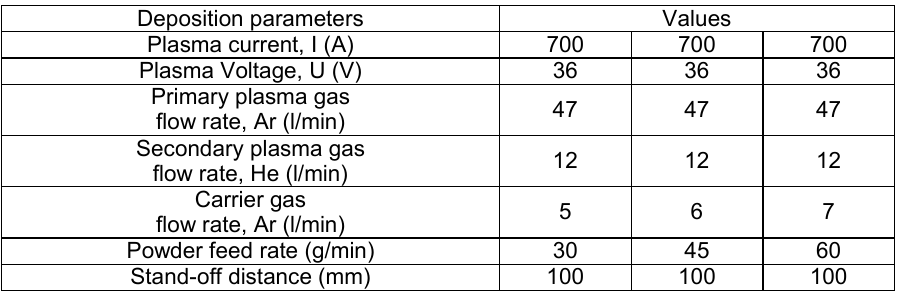
Table 1 – Plasma spray parameters Tabela 1 – Plazma sprej